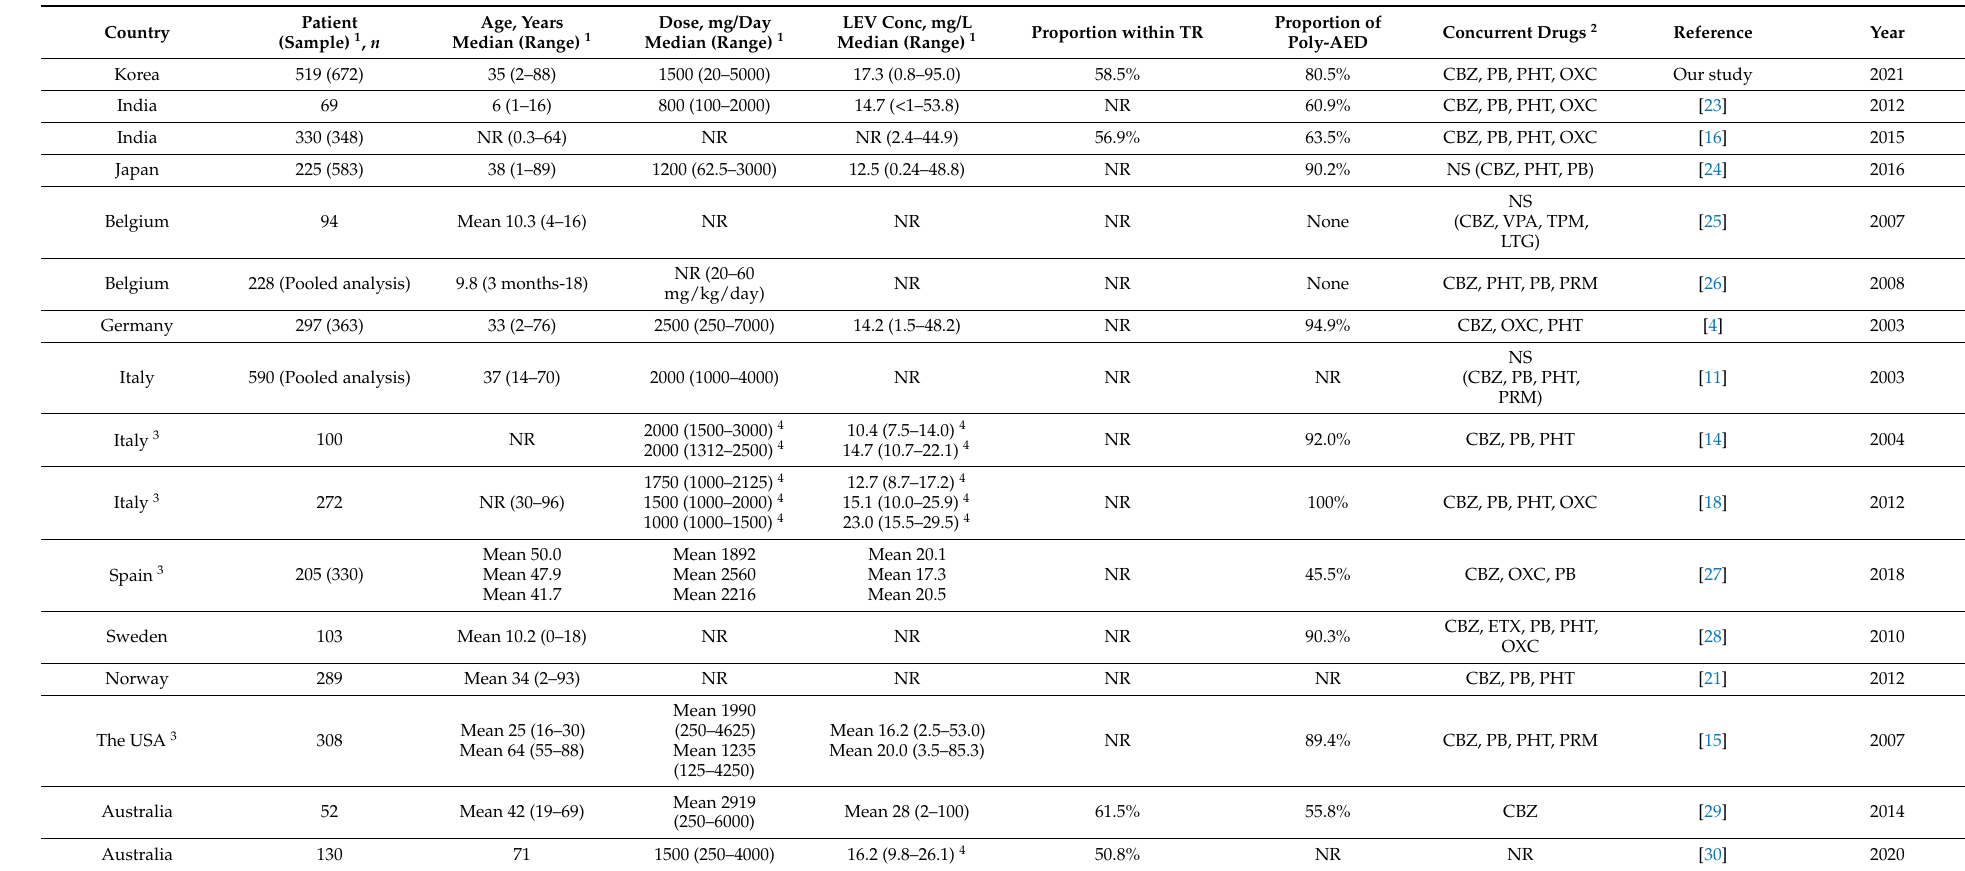
Table 4. Previous clinical studies of levetiracetam therapeutic drug